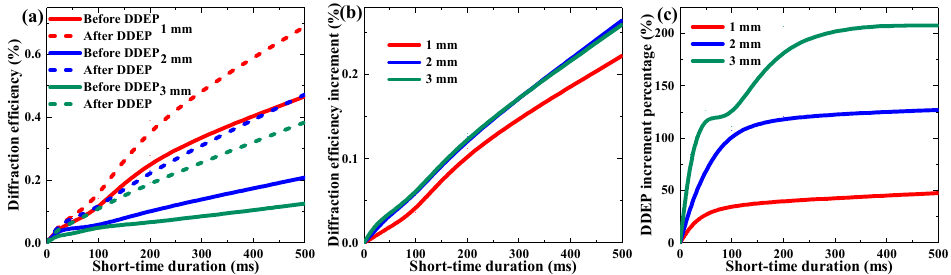
Figure 8. Effect of short-time duration on single shot DDEP of materials with different thickness: ( a ) maximum diffraction efficiency, ( b ) diffraction efficiency increment, ( c ) DDEP increment percentage.